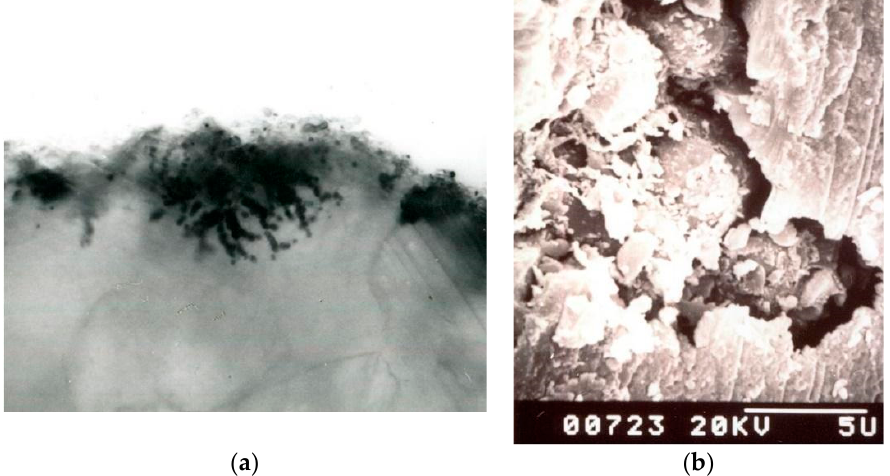
Figure 5. Microscopic observation of the endolithic behaviour of meristematic black fungi. ( a ) Settled on a thin section of Carrara marble sarcophagus flake showing the meristematic chains deepening inside the marble, magnification 400X; ( b ) SEM image showing MCF into the marble with dissolution pattern following the same shape of meristematic cells.